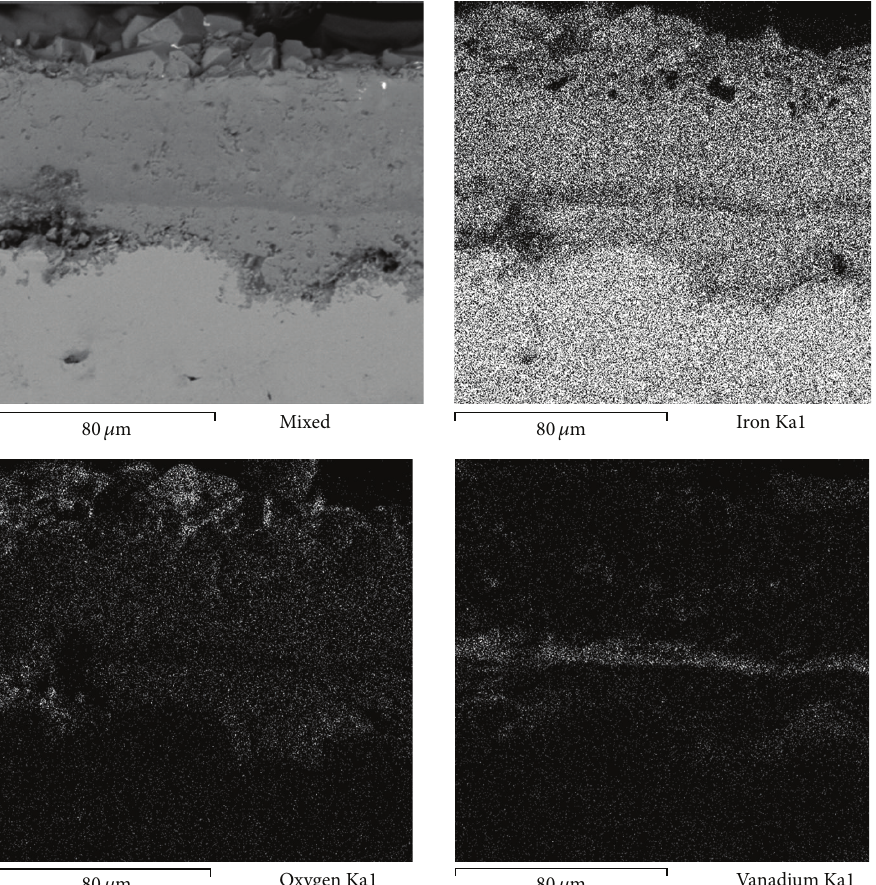
Figure 6: Electron image of the metal-scale interface and X-ray mappings of Fe, O, and V when pure metal iron was exposed to NaVO 3 at 700 ∘ C during 100